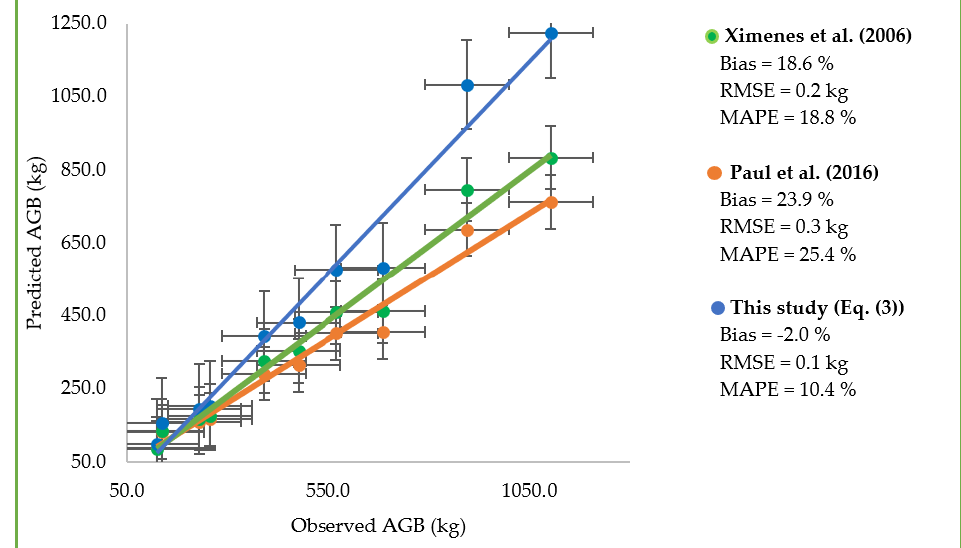
Figure 5. Validation and comparison of the D-based equation of this study and published equations in different regions in Australia, with spotted gum native forests [22] and mixed hardwood forests of Eucalyptus, Corymbia and Angophora [20]. The dataset was validated by the MCCV method with 20% random splitting data and the process was repeated 100 times to average the errors.